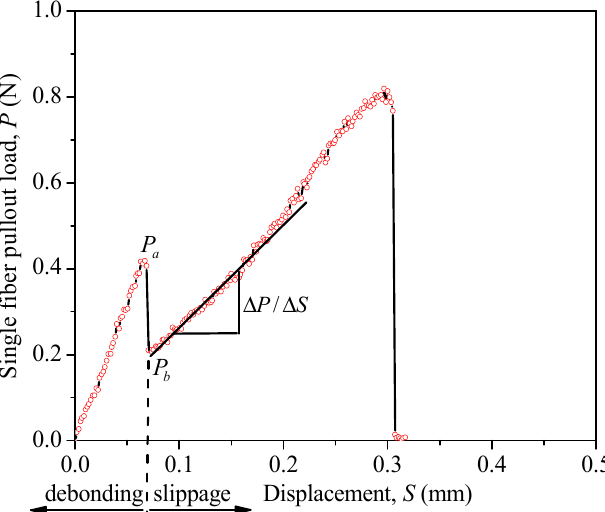
Figure 6. Typical single fiber pullout load–displacement curve.